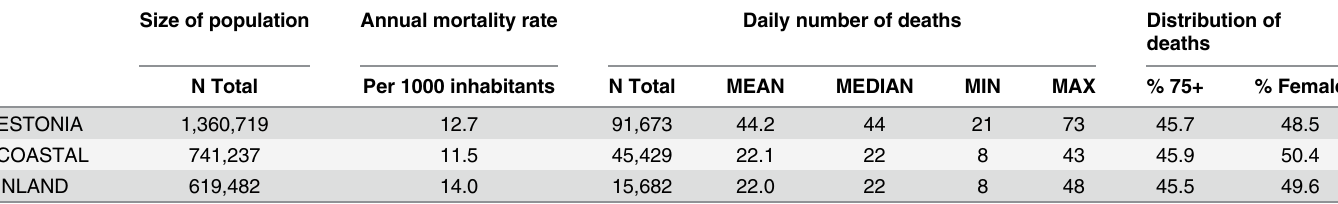
Table 2. Average mortality data for the period 1997 –